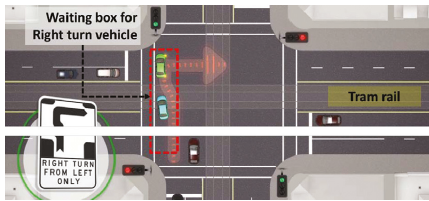
Figure 1: Typical traffic movements at the hook turn